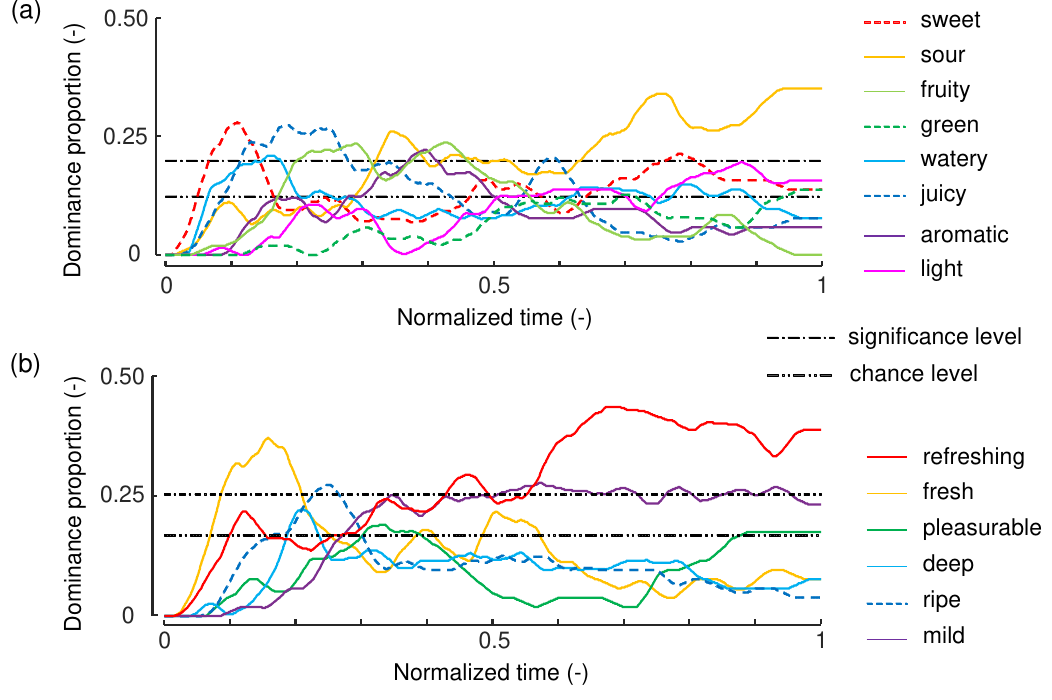
Figure 3. Dominance proportion curves for strawberries. ( a ) TDS curves of primary-sensations. ( b ) TDE curves of